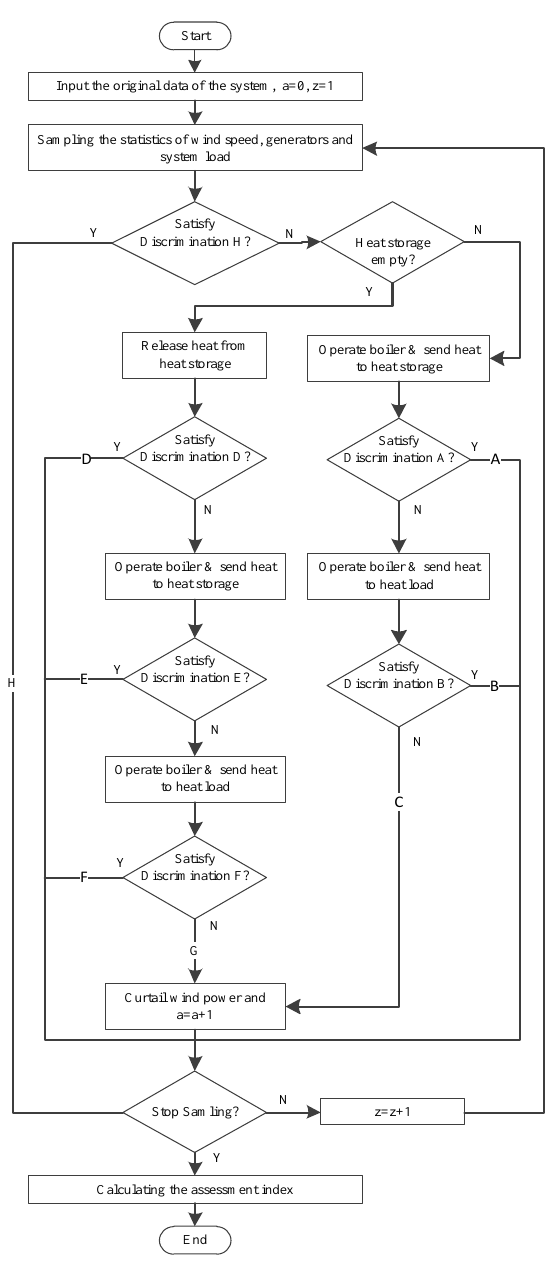
Figure 6. Flowchart of calculating the evaluation